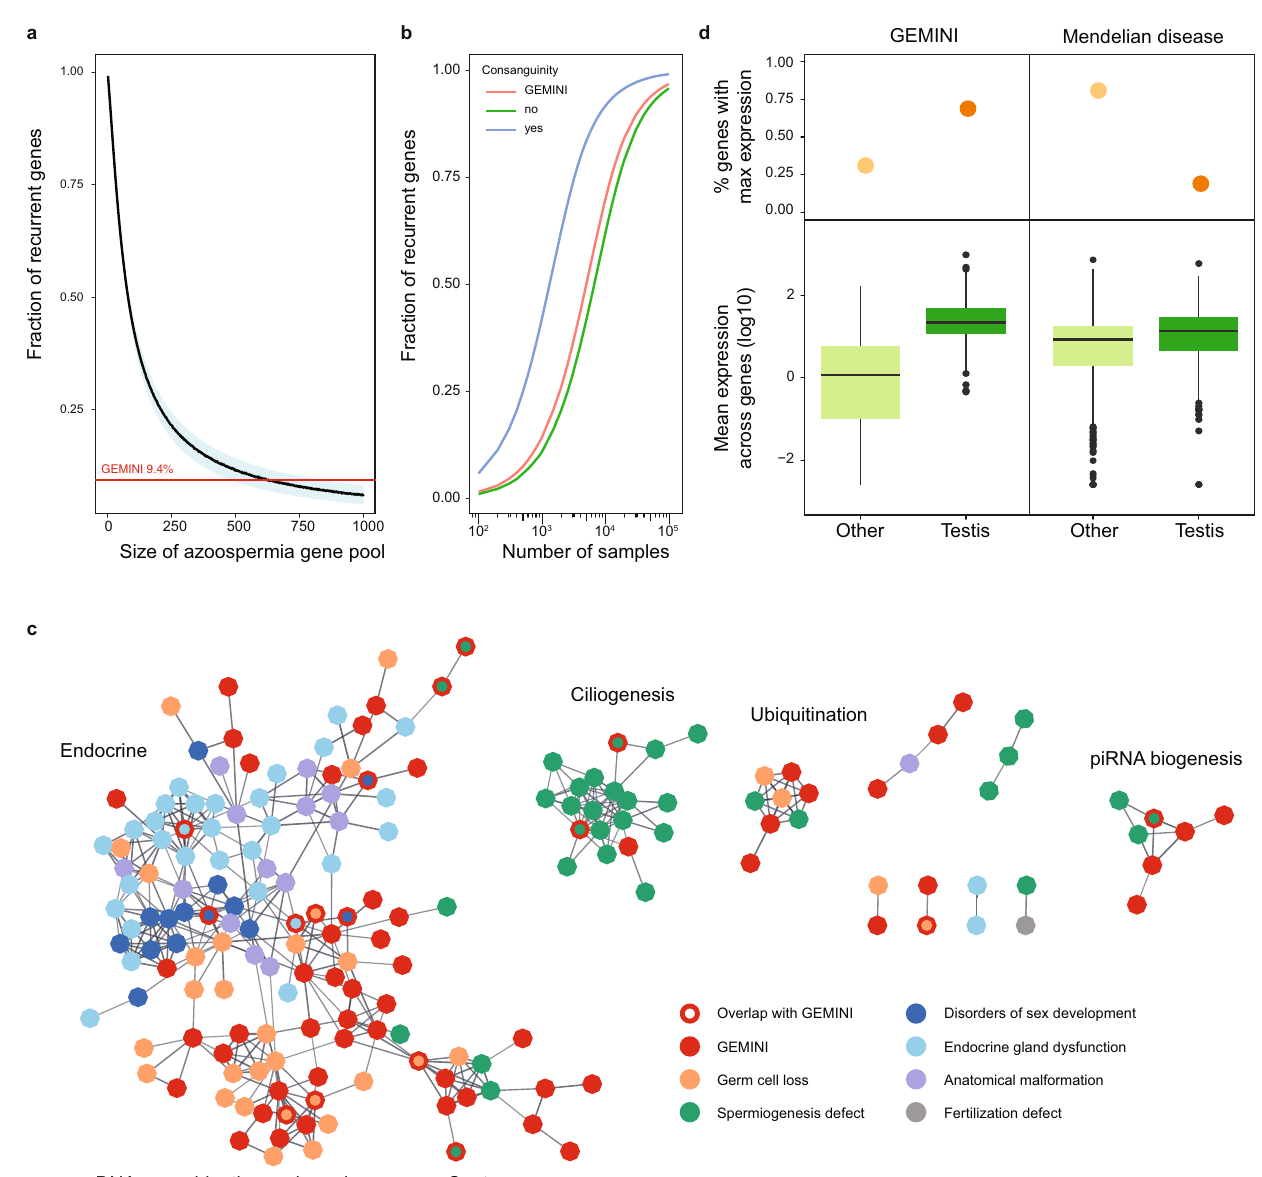
Fig. 3 | Characteristics of NOA genes in the context of male infertility and the broader Mendelian disease landscape. a Estimation of the total number of azoospermia genes. To detect 9.4% of genes recurrently in non-consanguineous cases with predominantly monogenic NOA, as seen in GEMINI, a gene pool of roughly 625 azoospermiagenes wouldbeexpected.Blue area represents standard deviation around the mean of 1000 iterations. b Projected number of samples required for observing recurrent gene hits in NOA cohorts considering the esti- mated pool of 625 azoospermia genes and discovery rates of 76% for con- sanguineous cases, 20% for GEMINI overall (8% of consanguineous cases) and 15%